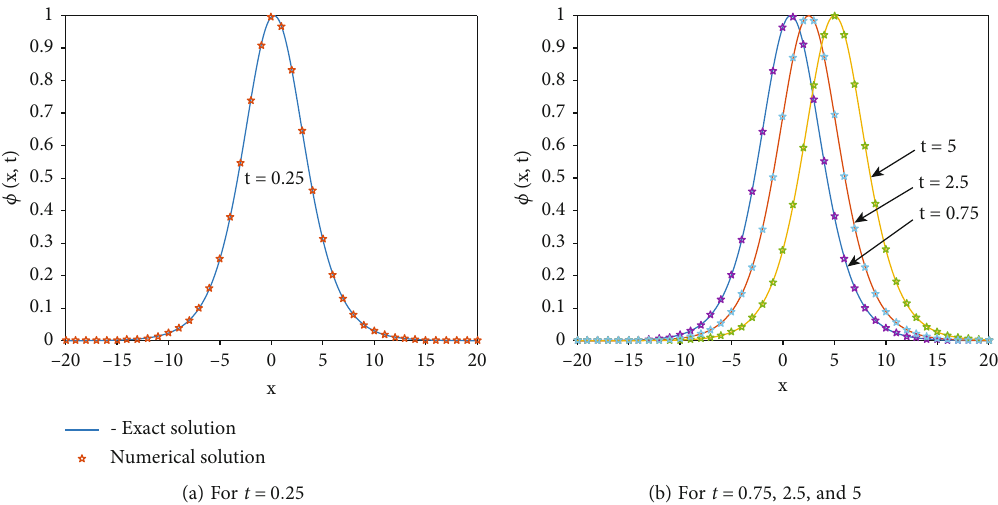
Figure 5: Approximate and classical results of time fractional BBMB-equation for α = 0 : 5 , Δ t = 0 : 01 , β = 1 , and h = 0 : 01 .